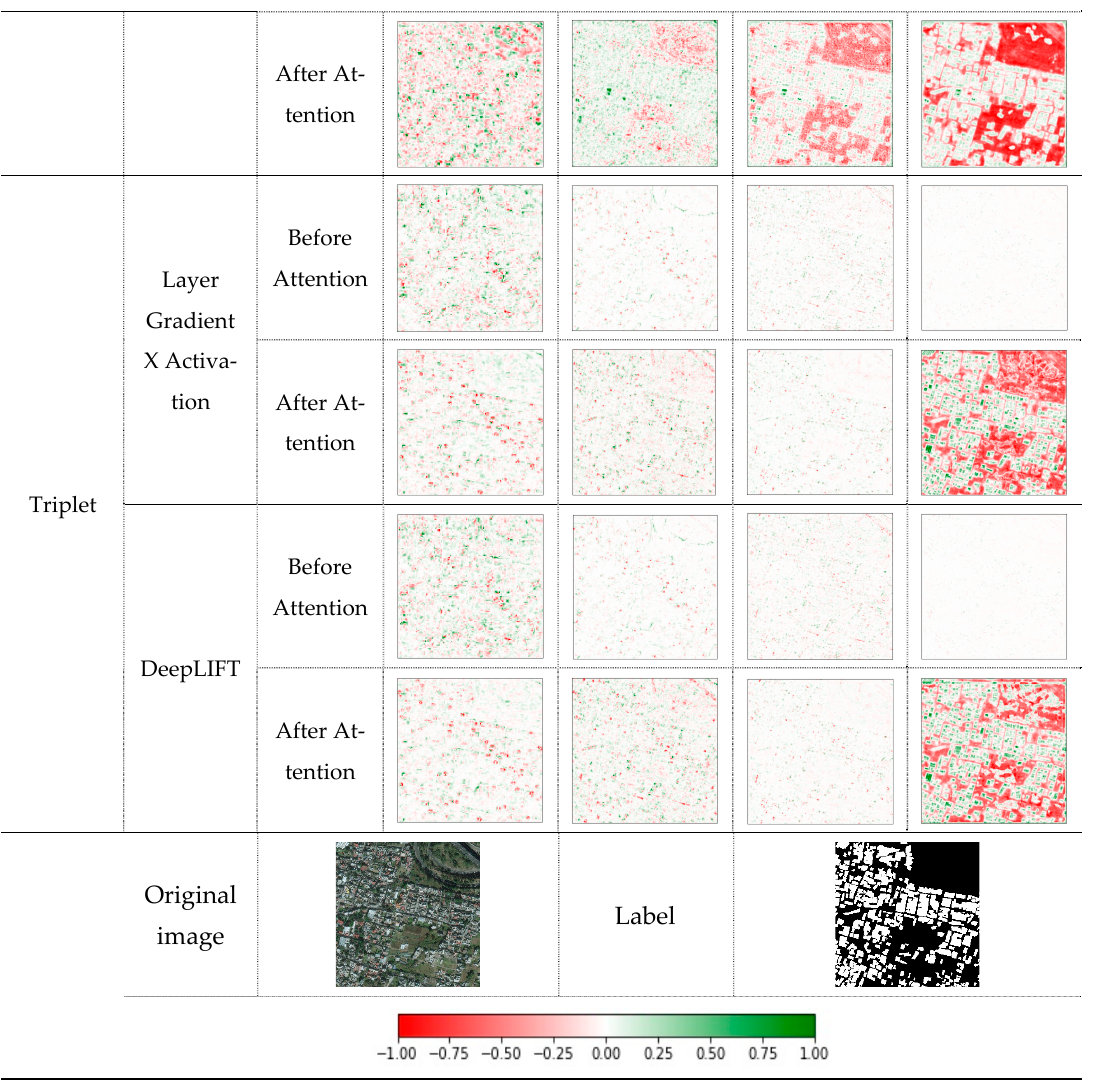
Figure 5. Visualization results of Gradient X Activation and LayerDeepLIFT before and after AMs on Unet. The numbers above the table (i.e., 1 st , 2 nd …) indicate the layer number of the attention in the framework.